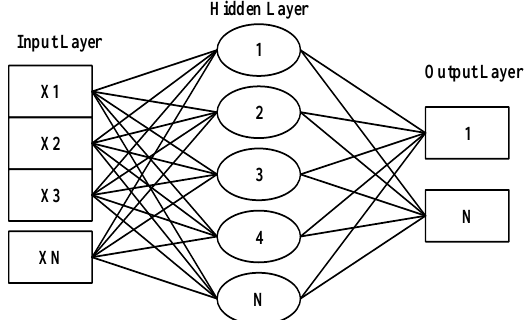
Figure.2 Structure of multilayer feed–forward back propagation algorithm.